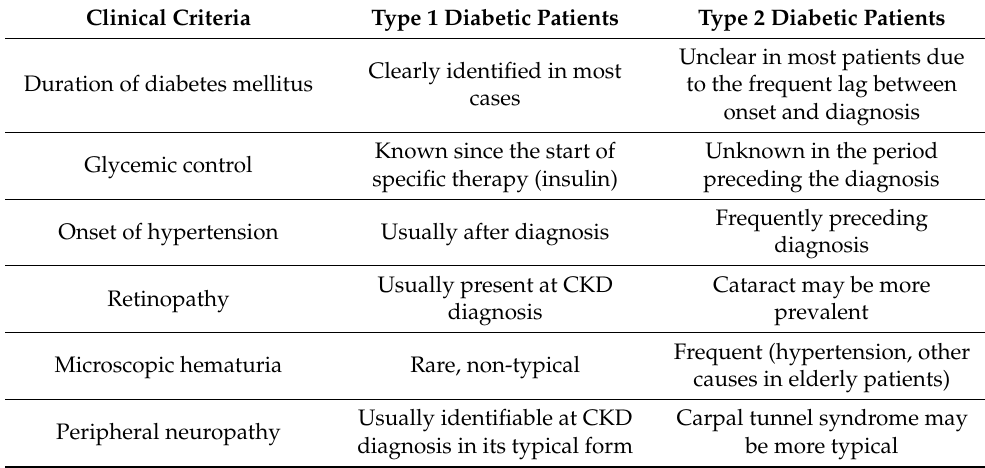
Table 3. Clinical differences between type 1 and type 2 diabetic patients presenting a diabetic kidney